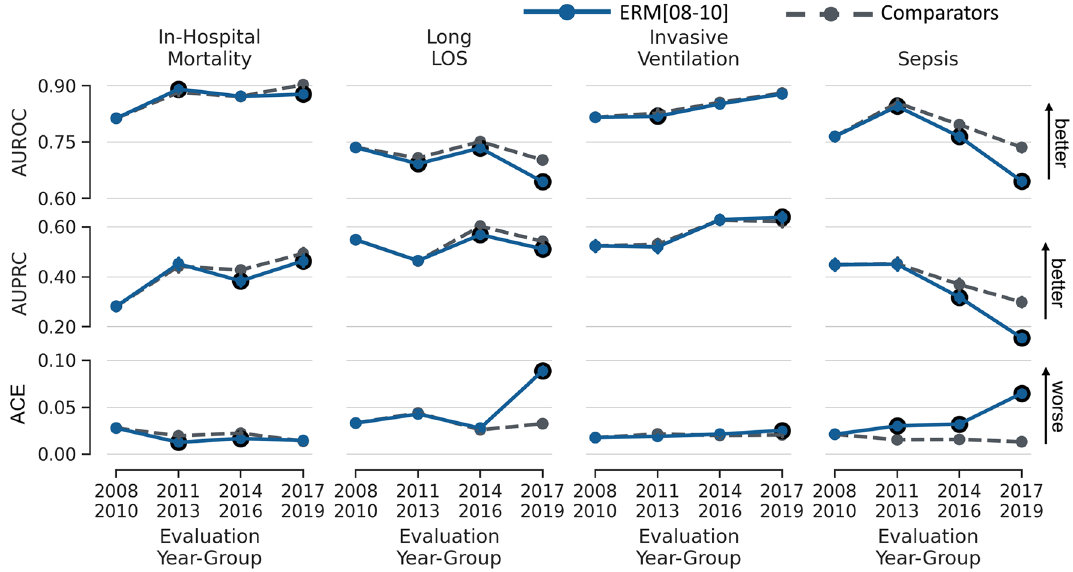
Figure 2. Mean performance (AUROC, AUPRC, and ACE) of models in the baseline experiment. Solid blue lines depict models trained using 2008–2010 (ERM[8–10]) and evaluated in each year group. Dashed lines depict models trained and evaluated in each year group separately (comparators). Error bars indicate 95% confidence interval obtained from 10,000 bootstrap iterations. Black circles indicate statistically significant differences in performance based on the 95% confidence interval of the difference over 10,000 bootstrap iterations when comparing ERM[8–10] and comparators for each year group. The figure shows temporal dataset shift that is larger for Long LOS and Sepsis tasks. ERM: empirical risk minimization; LOS: length of stay; AUROC: area under the receiver operating characteristics curve; AUPRC: area under the precision recall curve; ACE: absolute calibration